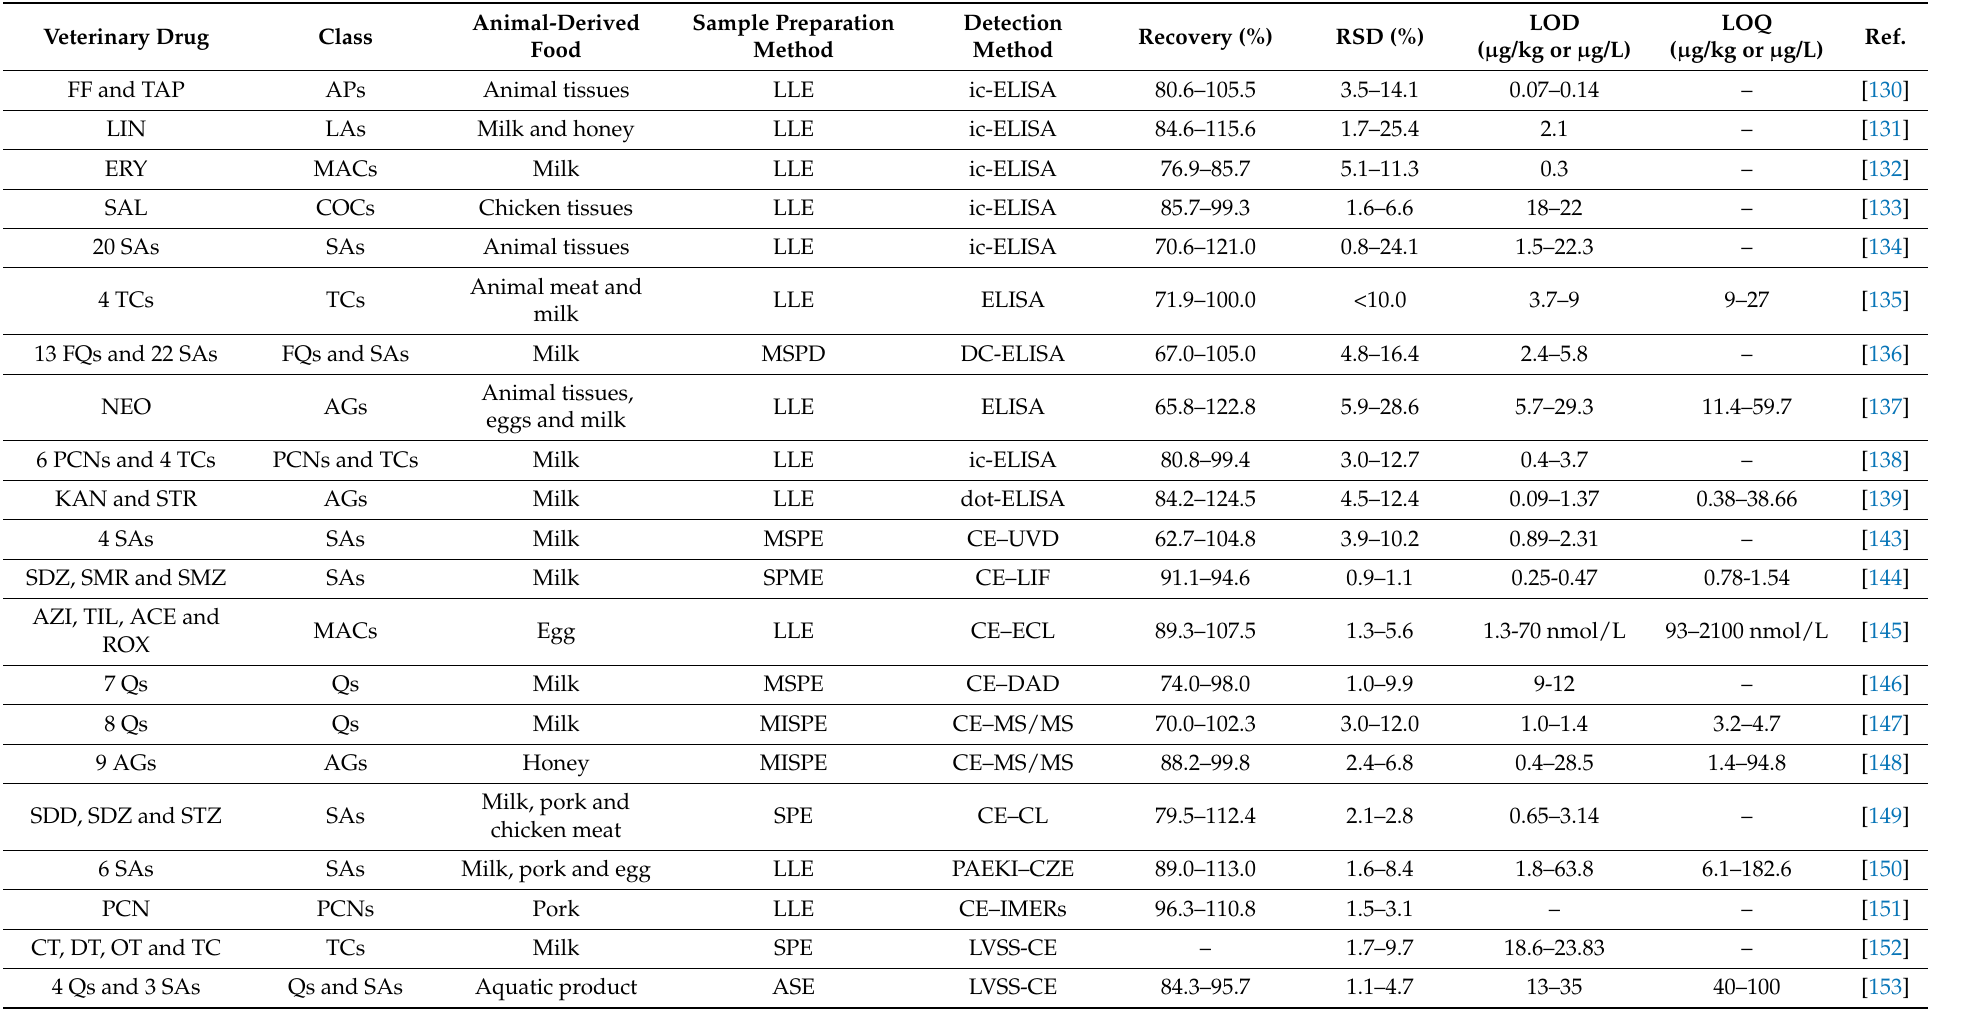
Table 5. Overview of published ELISA, CE and MEKC methods for the analysis of veterinary drugs in animal-derived